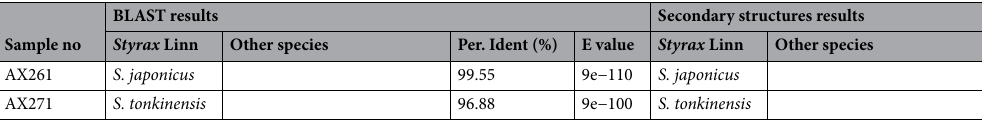
Table 2. Results of BLAST comparison and secondary structure analysis of ITS2 sequences of samples.